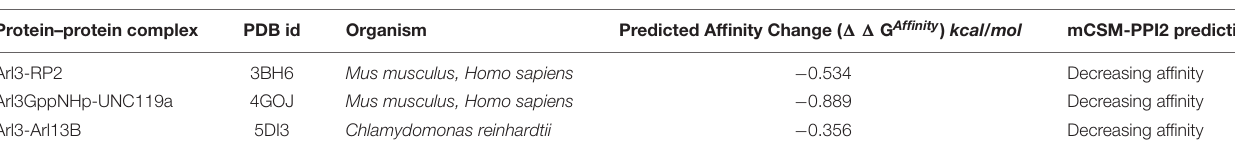
TABLE 3 | Prediction of the protein stability using mCSM-PPI2. Protein–protein